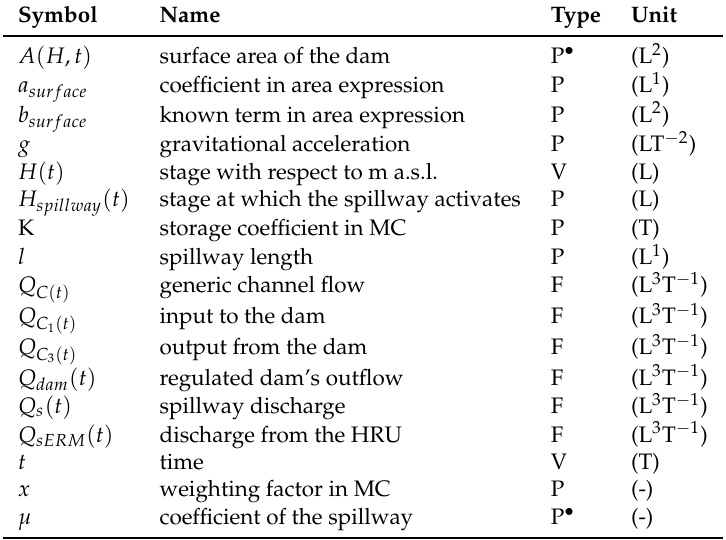
Table 4. List of symbols, names, and units used in the EPN representation in Figure 5.